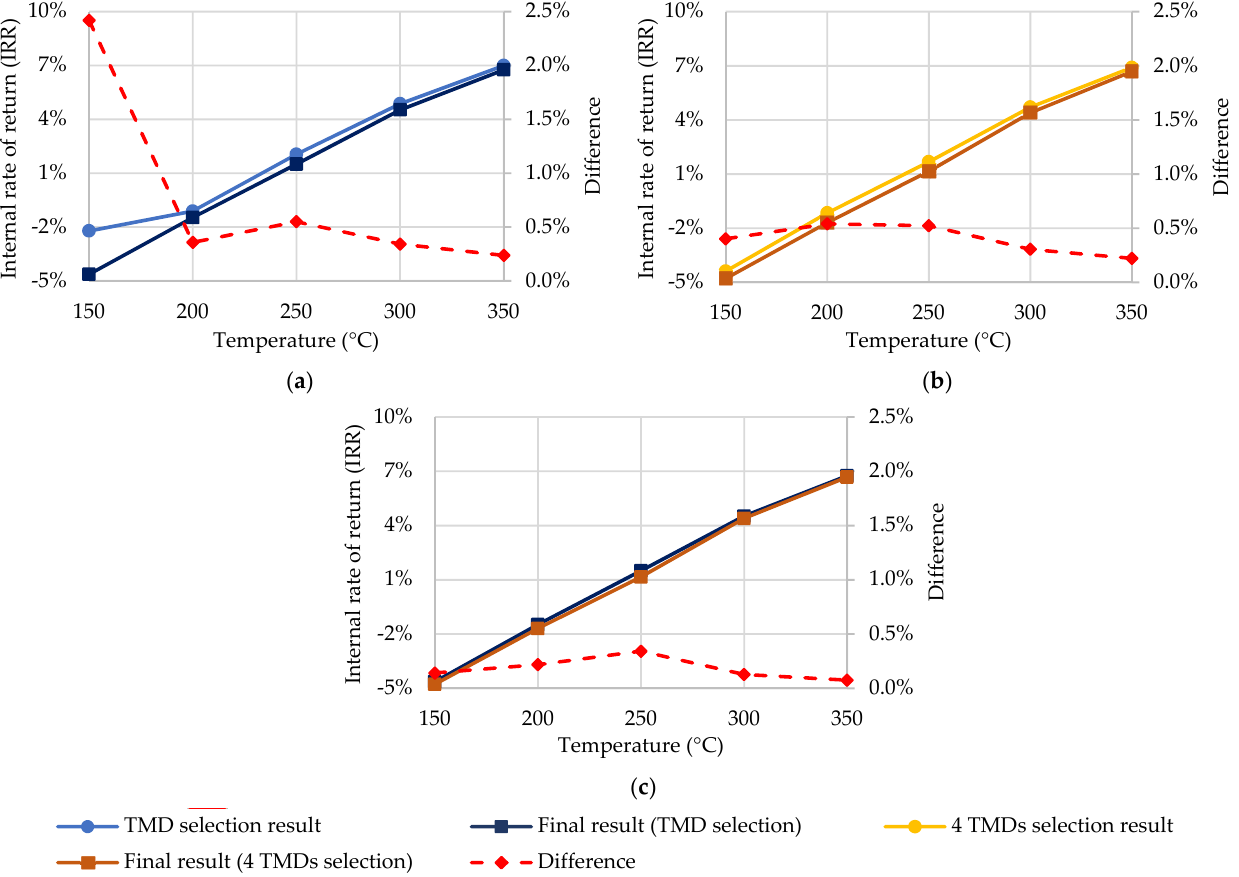
Figure 5. The energy price sensitivity analysis.